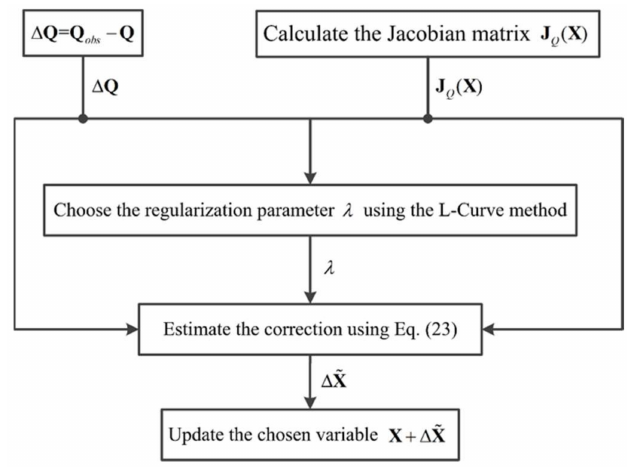
Figure 2. Flowchart of the regularized DSRC (RDSRC) method.